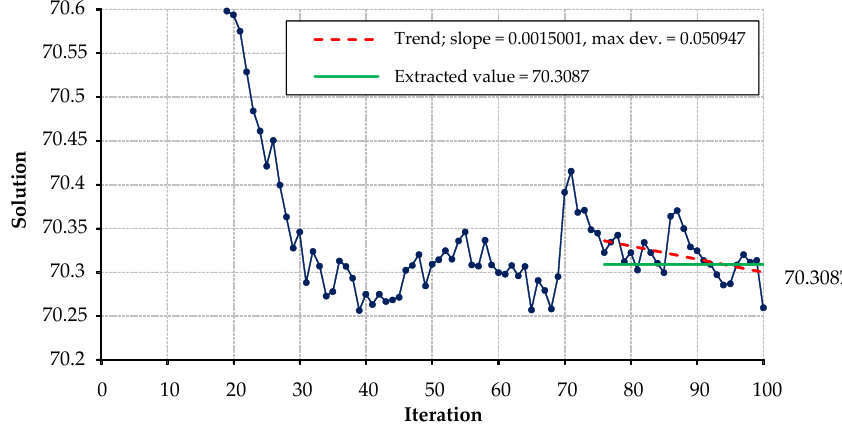
Figure 20. Filter used to extract the solutions from the convergence histories.